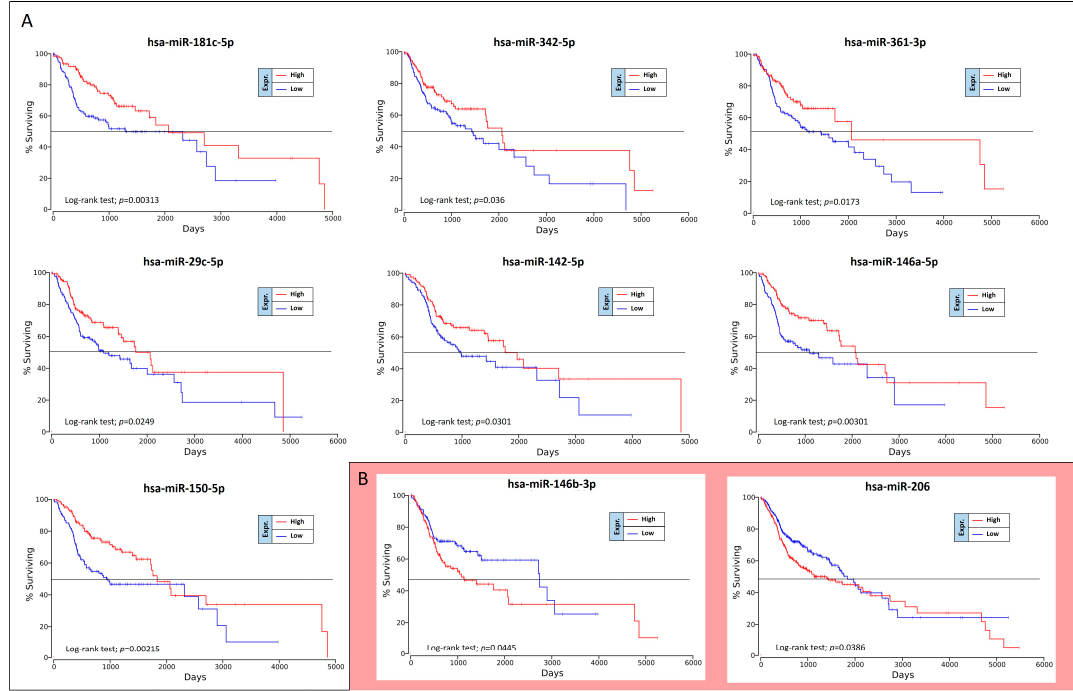
Figure 5. Survival analysis performed by OncoLnc. Panel ( A ) down-regulated miRNAs statistically associated with patients’ overall survival (OS) whose expression is concordant with survival curves; panel ( B ) miRNAs statistically associated with patients’ OS whose expression levels are not concordant with the survival curves.